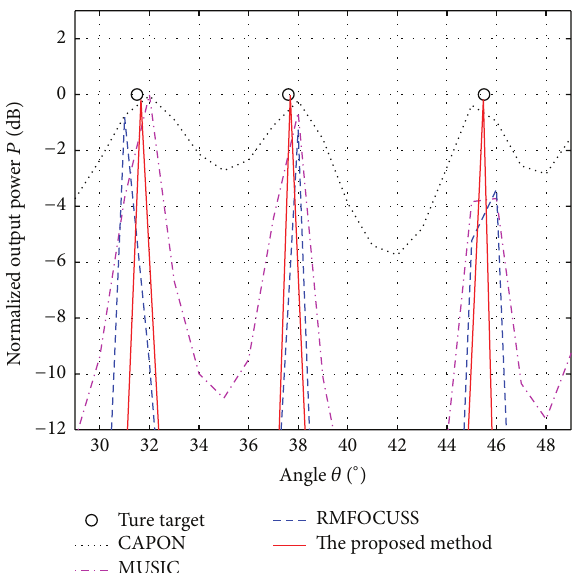
Figure 1: Angle resolution of estimated spatial